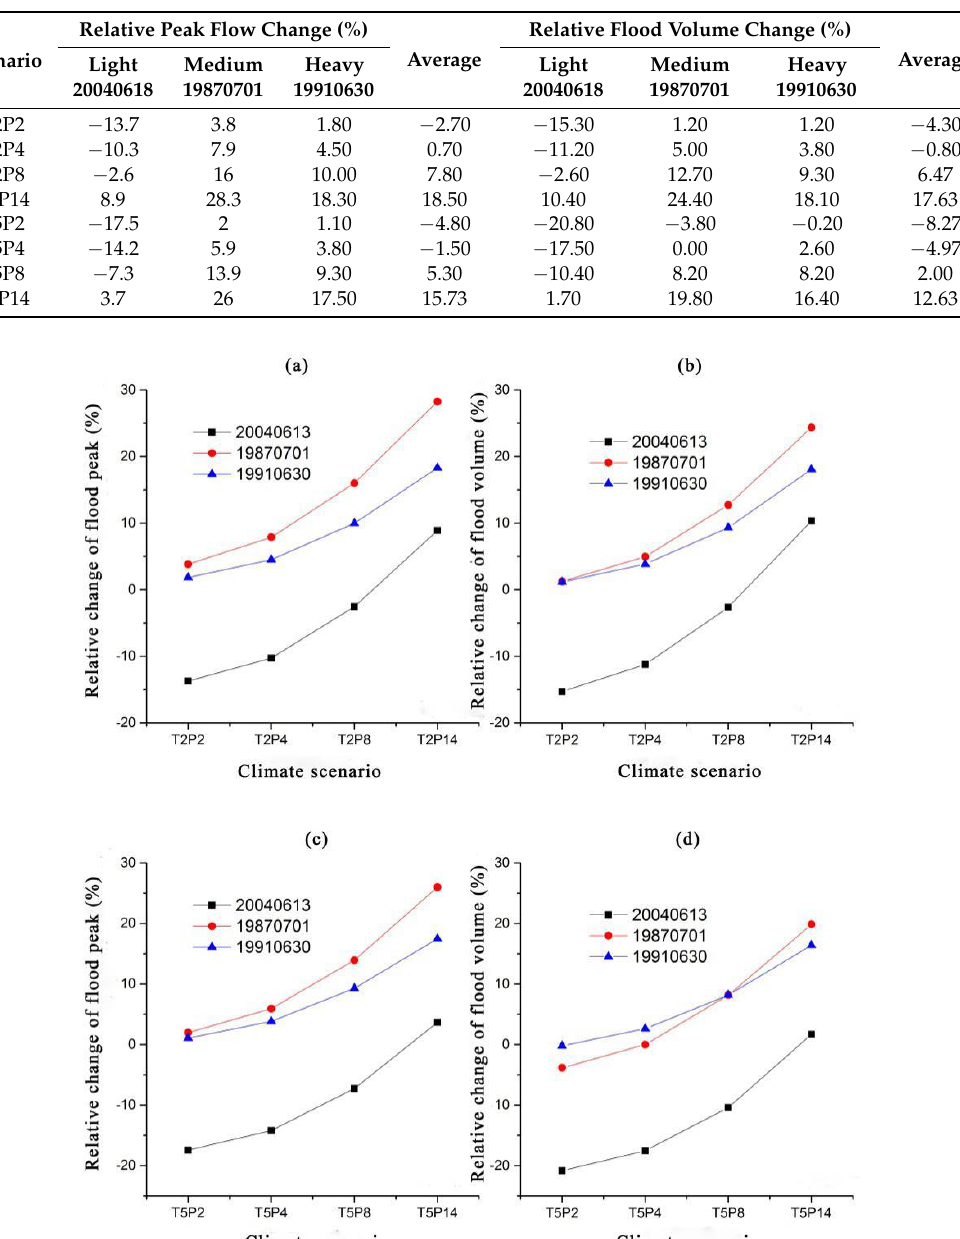
Table 6. Relative flood change when both temperature and precipitation increase. Relative peak flow change (%) Scenario